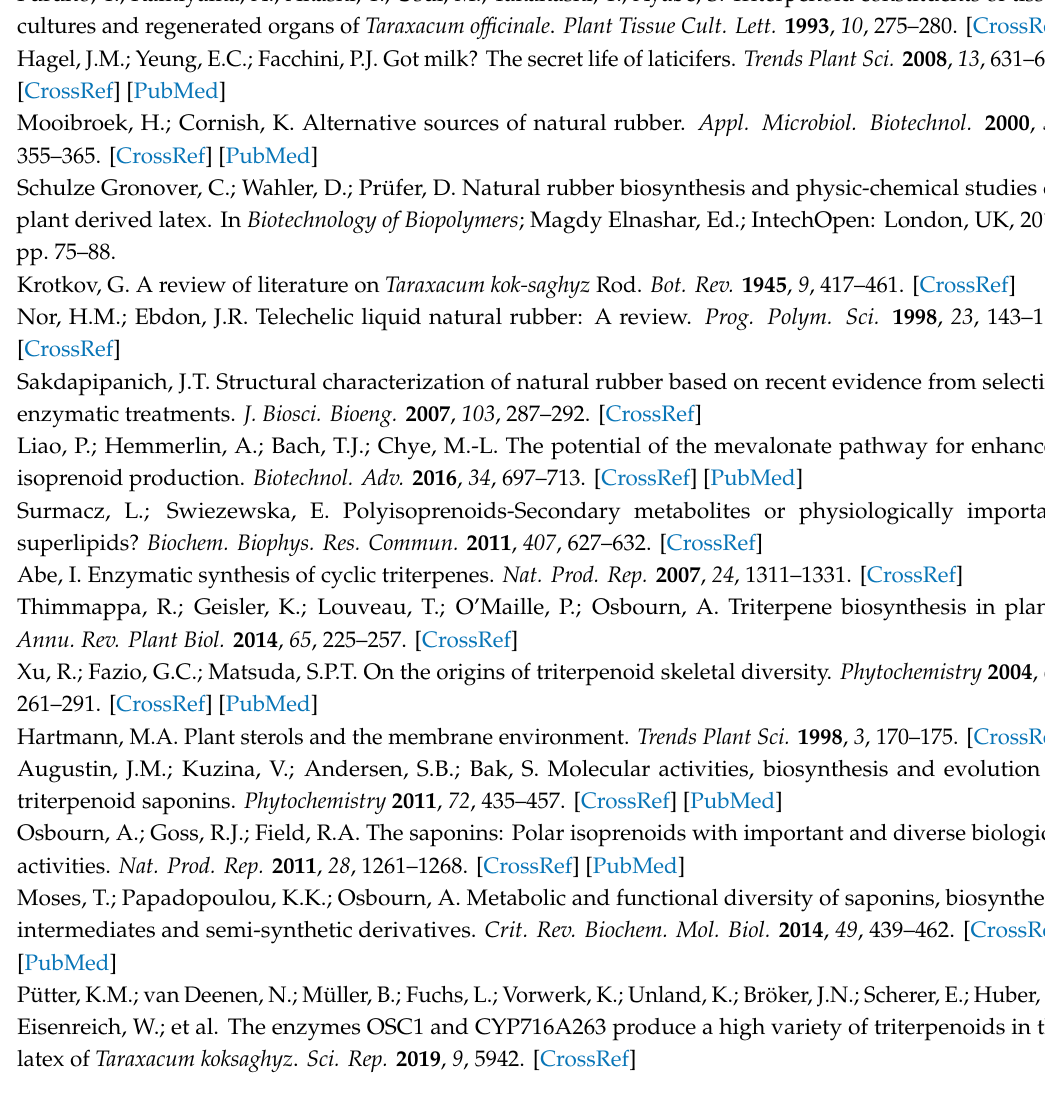
Supplementary Materials: The following are available online, Table S1: Triterpene content of root material from TkOSC1- RNAi plants compared to WT material, Table S2: Triterpene content of root material from TkOSC- RNAi plants compared to WT material, Table S3: Triterpene content in NR acetone extracts from TkOSC1 / TkOSC- RNAi plants compared to WT material, Table S4: Triterpene content in NR acetone extracts from TkOSC -RNAi plants in T1-generation compared to NIL material, Table S5: Sequences of oligonucleotides used for cloning and quantitative RT-PCR, Table S6: Primer e ffi ciency and amplification factors for cDNA obtained from T. koksaghyz